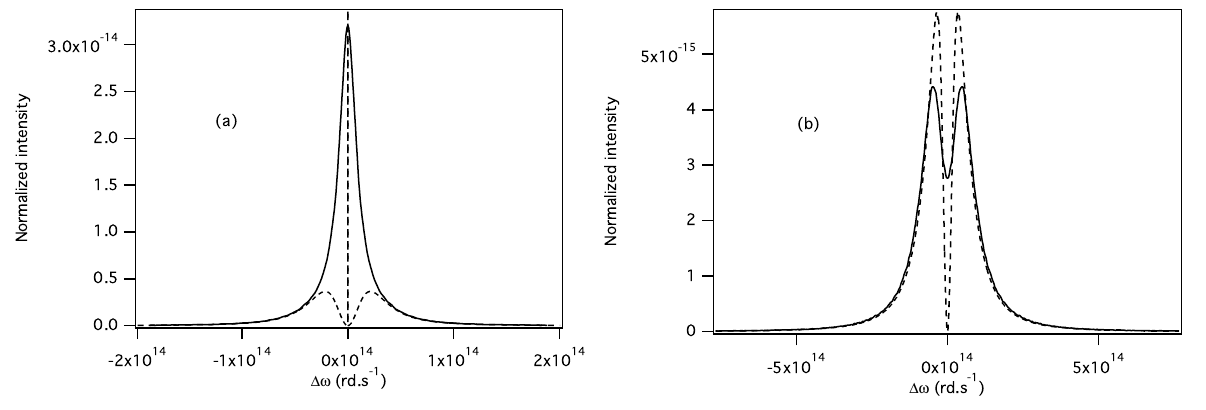
Figure 2. Spectral line shapes of the Lyman- α ( a ) and Lyman- β line ( b ) of hydrogen-like Helium calculated in a quasi-static (dash line) and in a fluctuating (full line) ionic electric field produced by protons at n = 10 19 cm − 3 and T = 10